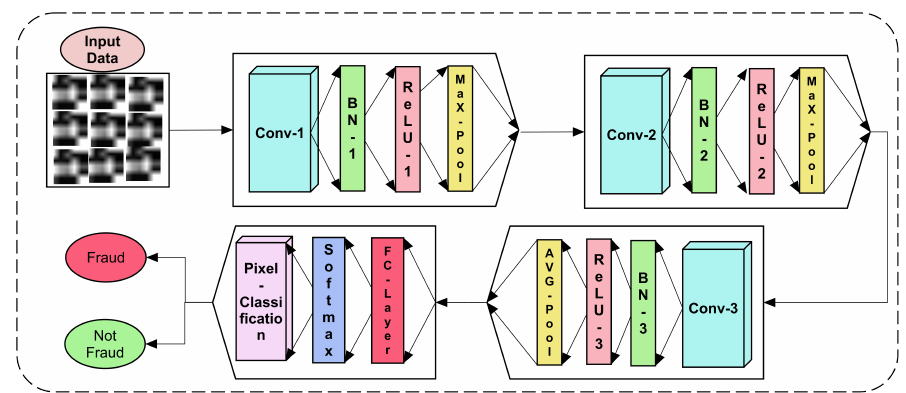
Figure 2. The proposed 16-layer CNN architecture.